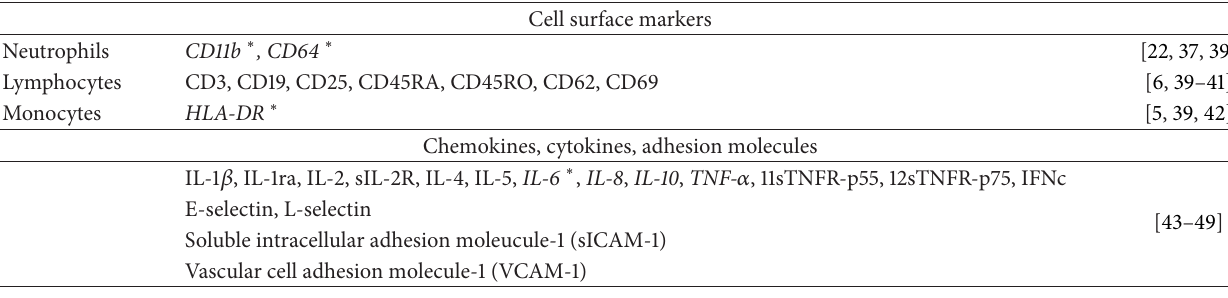
Table 2: Cell surface markers, chemokines, cytokines, and adhesion molecules were found to play a role in neonatal sepsis pathogenesis; ∗ might even be relevant in diagnostic use, and thus, is described in the